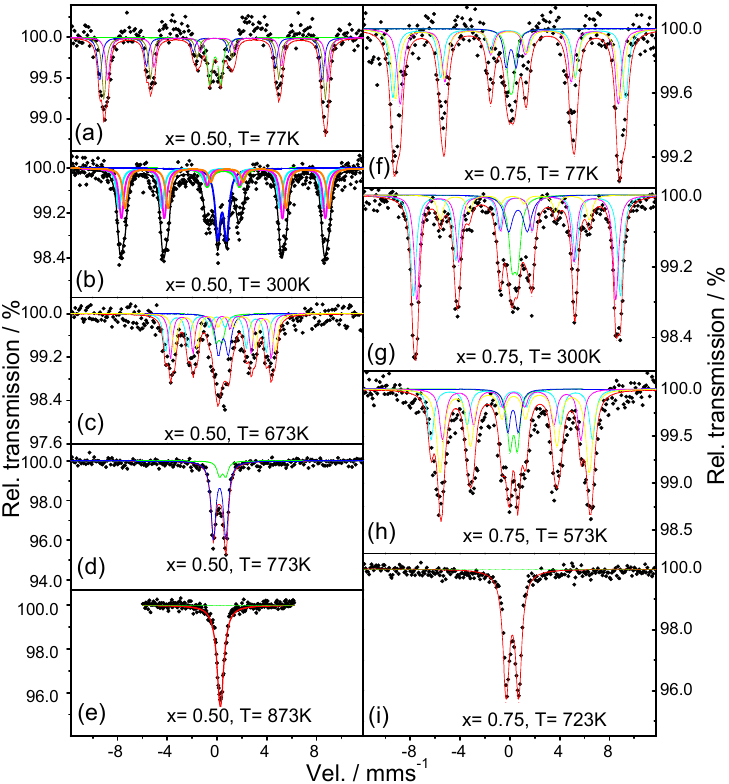
Figure 6. Mössbauer spectra for Sr 1 − x Ba x FeO 2 F: ( a – e ) x = 0.50 and ( f – i ) x = 0.75.